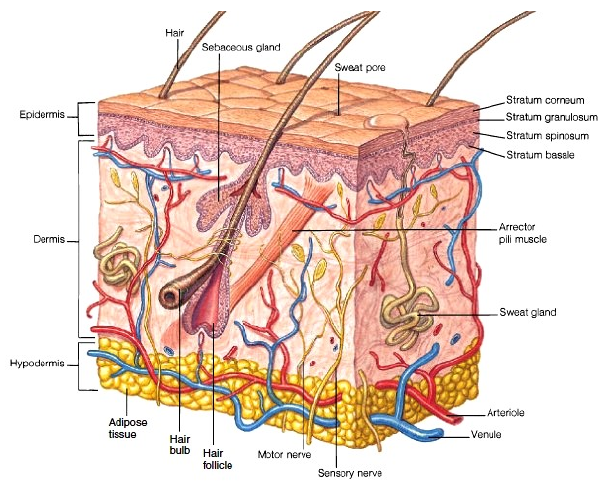
Figure 1: A cross section of animal tissue showing different layers including skin. [6]